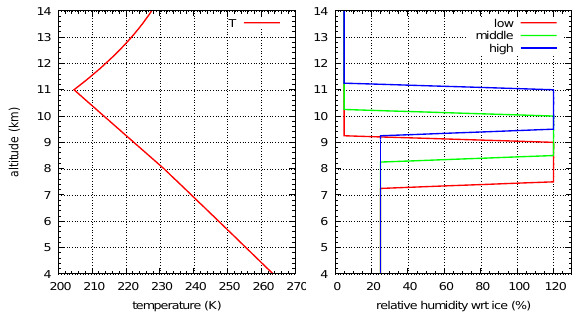
Fig. 8. Initial vertical profiles for the simulations; left: temperature, middle: pressure, right: relative humidity with respect to ice for dif- ferent set-ups (low, middle and high altitude range, corresponding to high, medium and low temperature range, see Table 1).